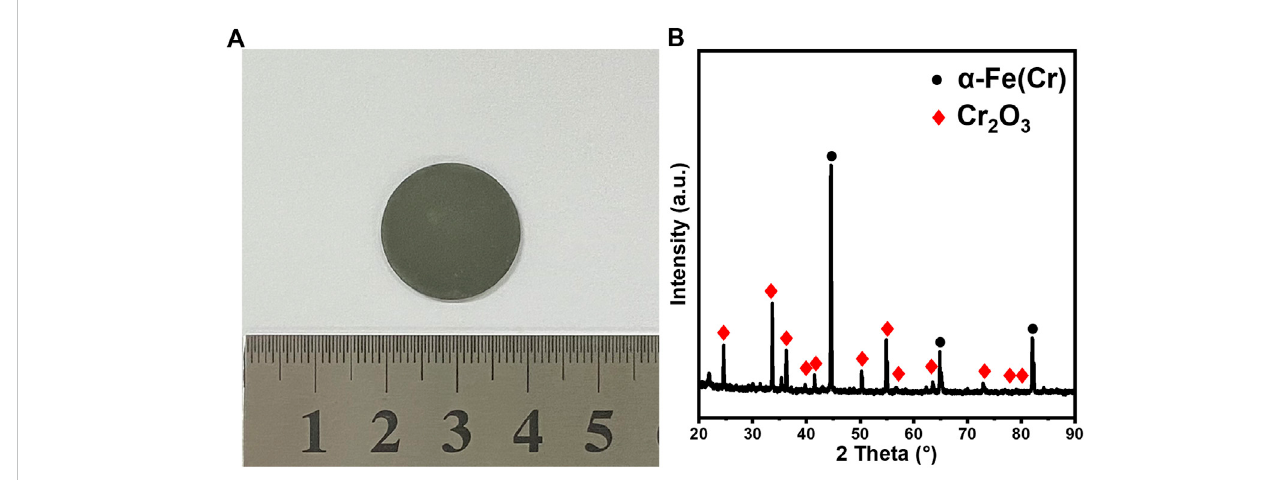
FIGURE 2 SS430L porous support after being sintered at 1350 ° C for 3 h under the raw and non-puri fi ed 5% H 2 /Ar gas mixture: (A) optical image; (B) XRD pattern. The raw materials contain 24 wt.% starch (based on